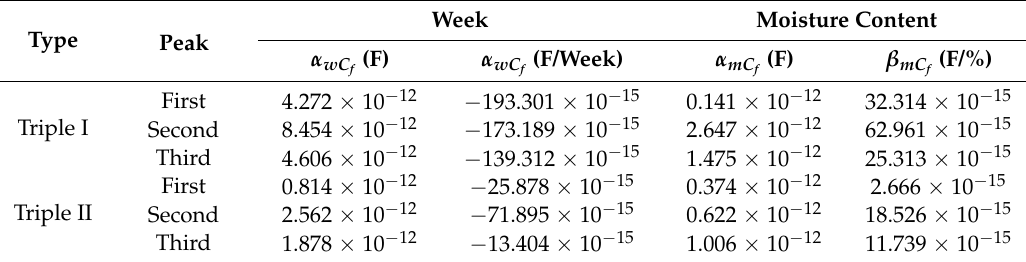
Figure 15. Triple II 1st, 2nd and 3rd fruitlet capacitance against the weeks ( a – c ) and moisture ( d – f ). Table 7. Triple coil αβ line fit value for fruitlet capacitance against the weeks and moisture